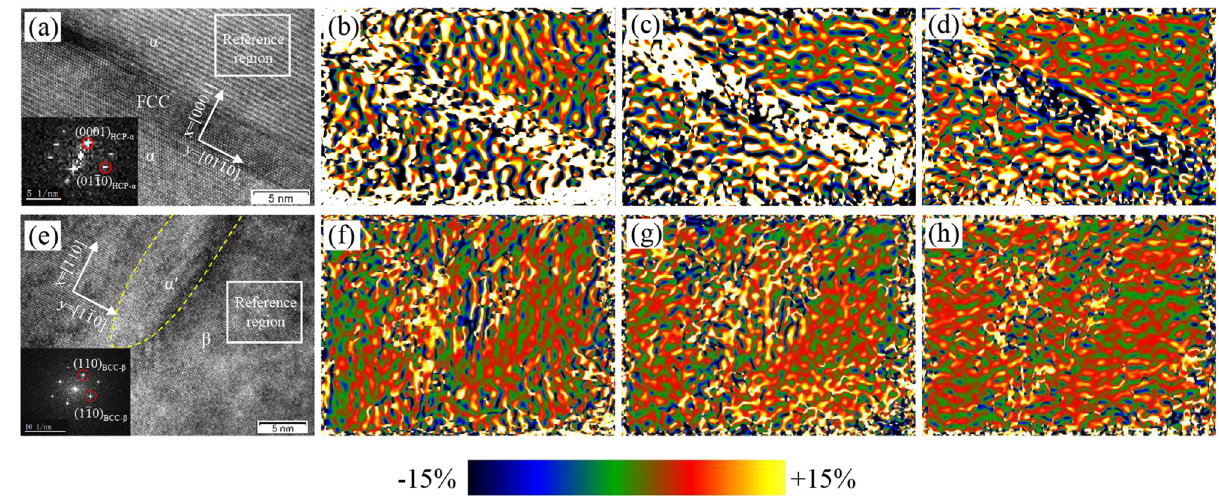
Figure 8: The strain fi elds of FCC + α and α ′ + β regions obtained by the geometric phase analysis: ( a ) and ( e ) HRTEM images corresponding to FCC + α and α ′ + β , ( b – d ) the strain component ε xx , ε xy , and ε yy of ( a ) , and ( f ) – ( h ) the strain component ε xx , ε xy , and ε yy of ( e )